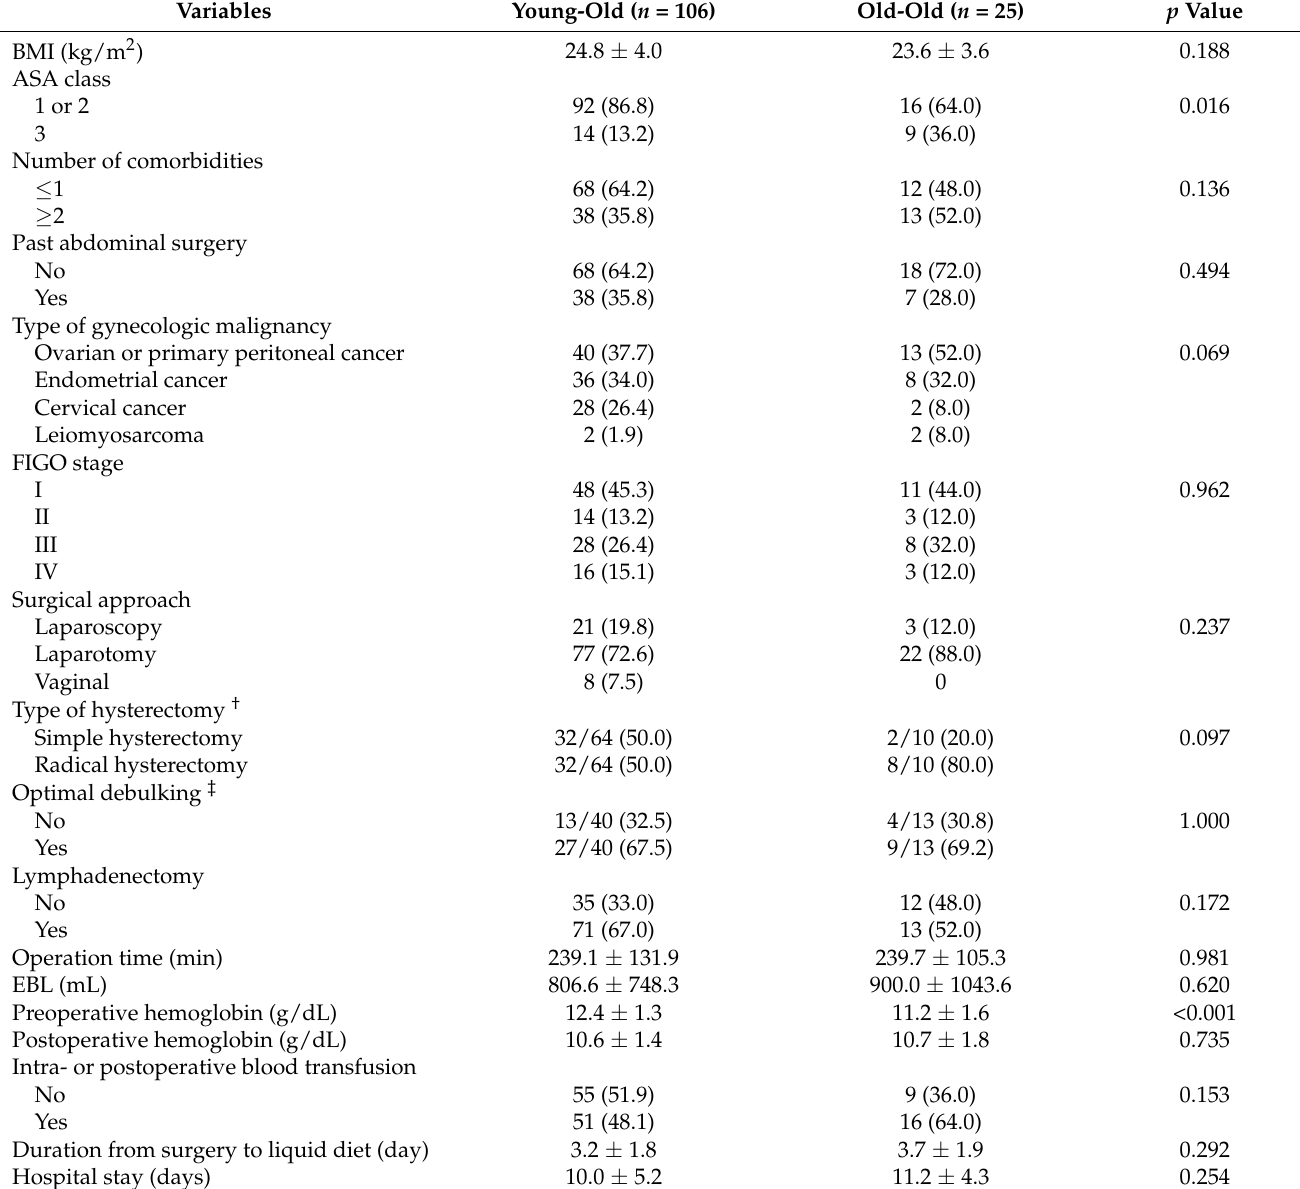
Table 3. Comparison of clinical characteristics and surgical outcomes between the young-old and old-old